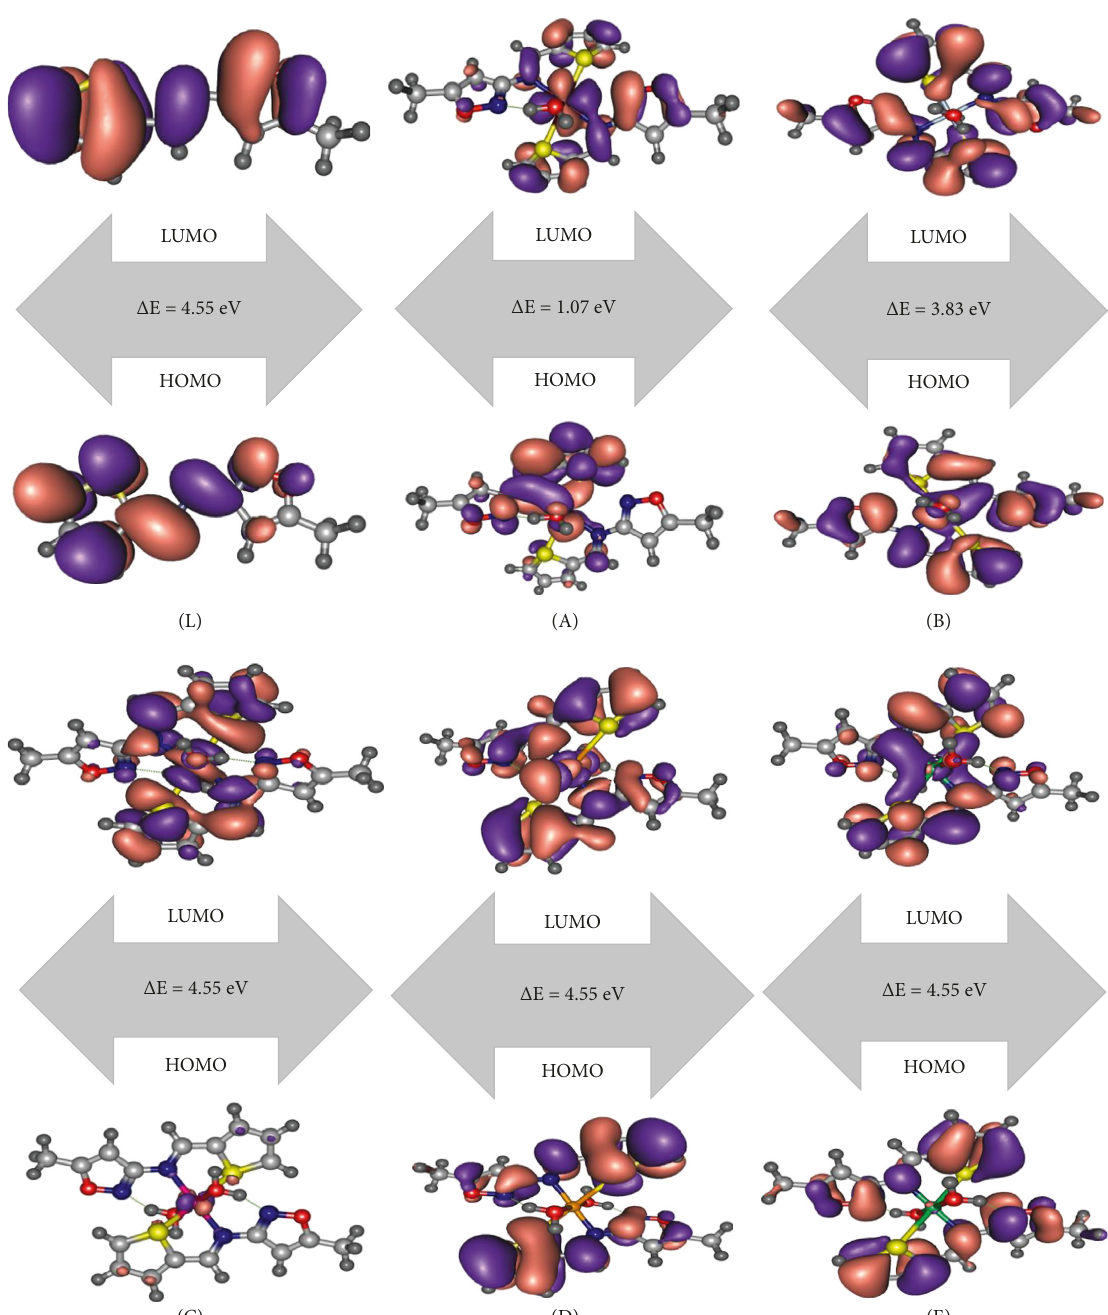
Figure 2: Gas-phase contour plots of HOMO and LUMO orbital diagrams of all investigated molecules at the M06/def2-TZVP/D3ZERO level of theory.